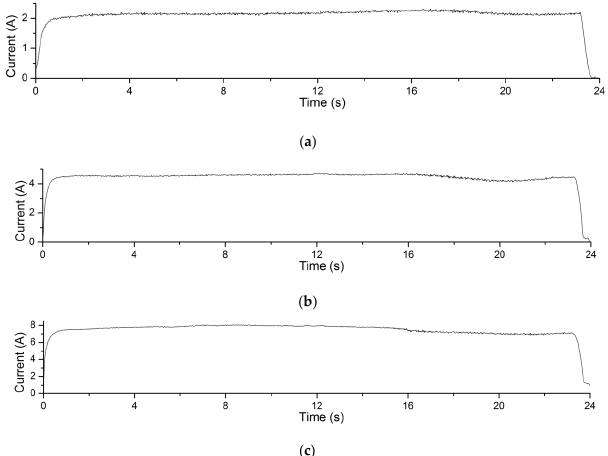
Figure 12. Processing current curves of electrolysis reactions in EMAF process. ( a ) The current curve when processing voltage is 4 V; ( b ) the current curve when processing voltage is 5 V; and ( c ) the current curve when processing voltage is 6 V.